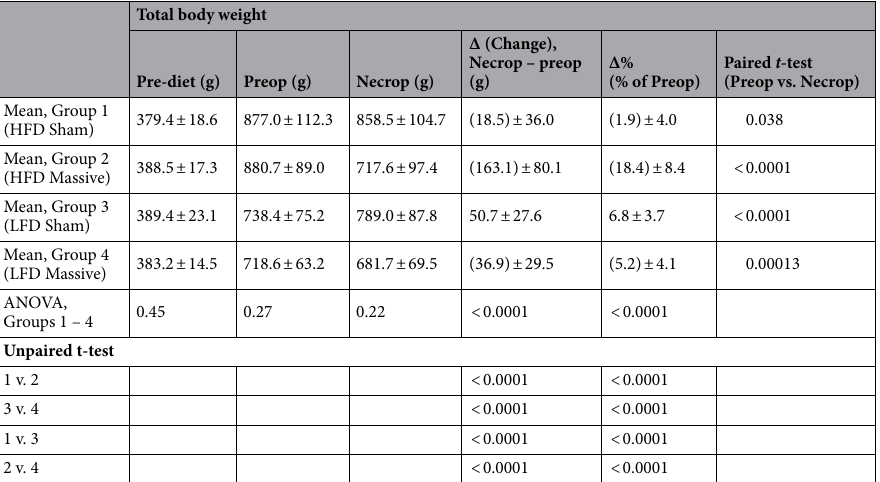
Table 5. Effect of diet and resection on total body weight. Values shown are mean ± standard deviation. Red values in parentheses (xx.x) represent a negative change (decrease). Pre-Diet = prior to the 6-mo dietary induction period; Preop = Preoperative (after dietary induction, immediately prior to resection); Necropsy = immediately prior to necropsy (two months after resection); HFD = High-Fat Diet; LFD = Low-Fat Diet; Massive = Massive 75% distal small intestinal resection; Sham = Sham resection.